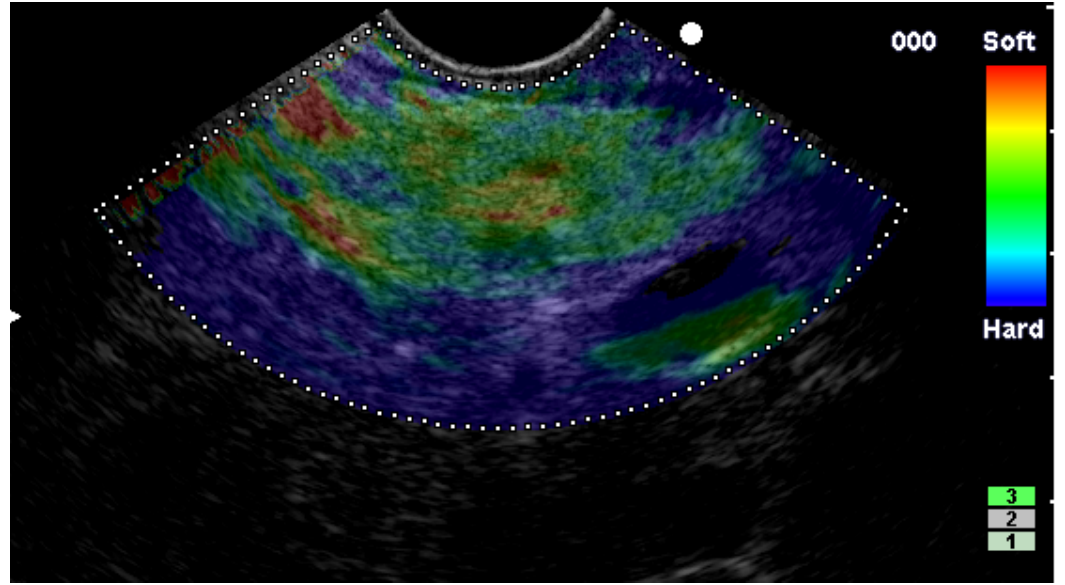
FIGURE 11 . Score 1: normal pancreatic